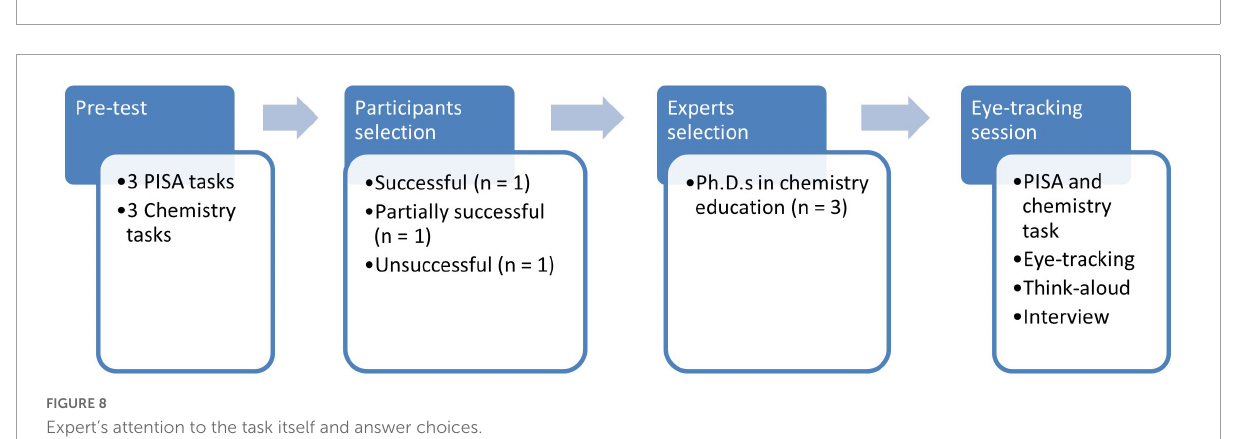
FIGURE7 Student’s attention to the answers’ choices.